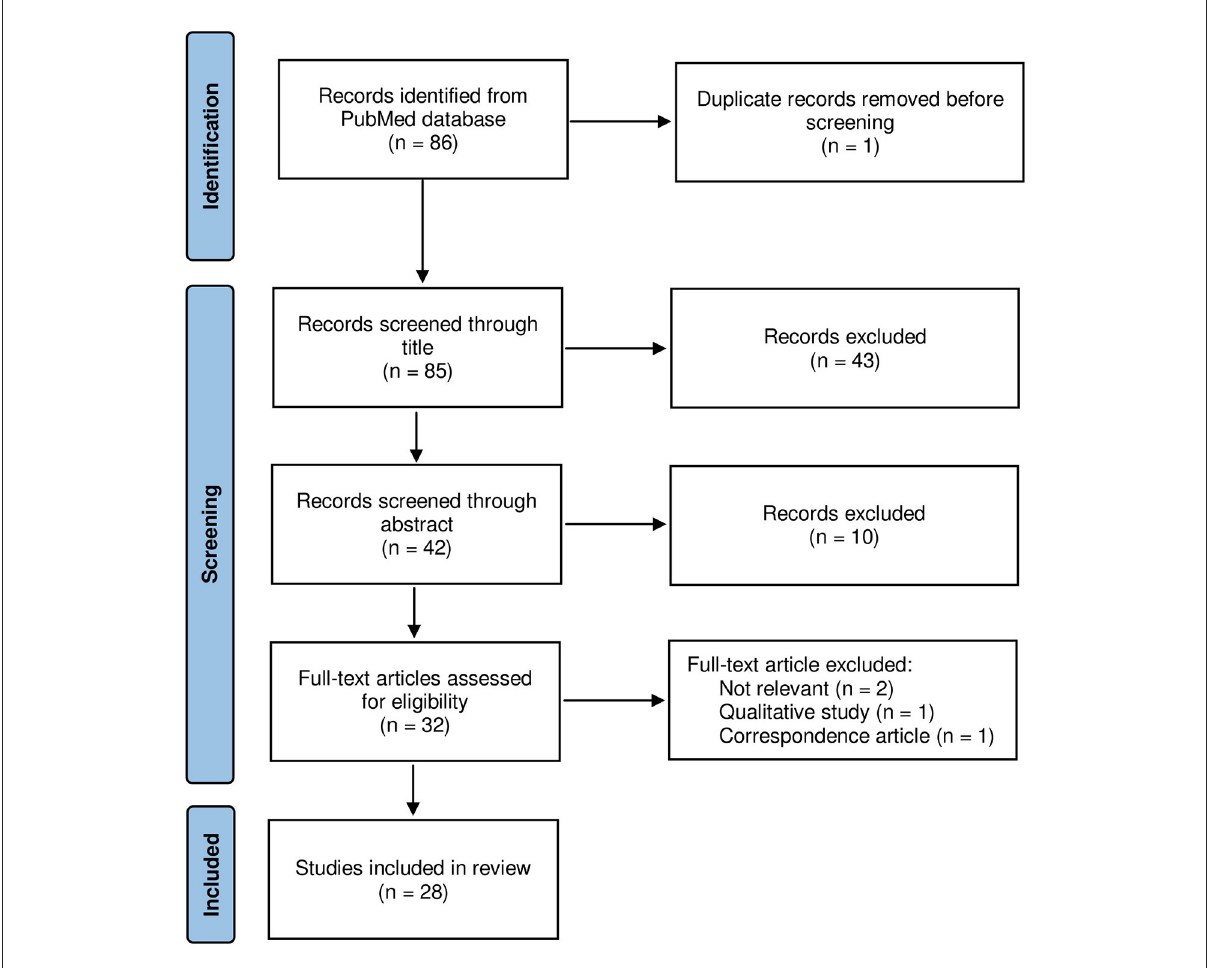
FIGURE1 Flowchart of the studies’ selection